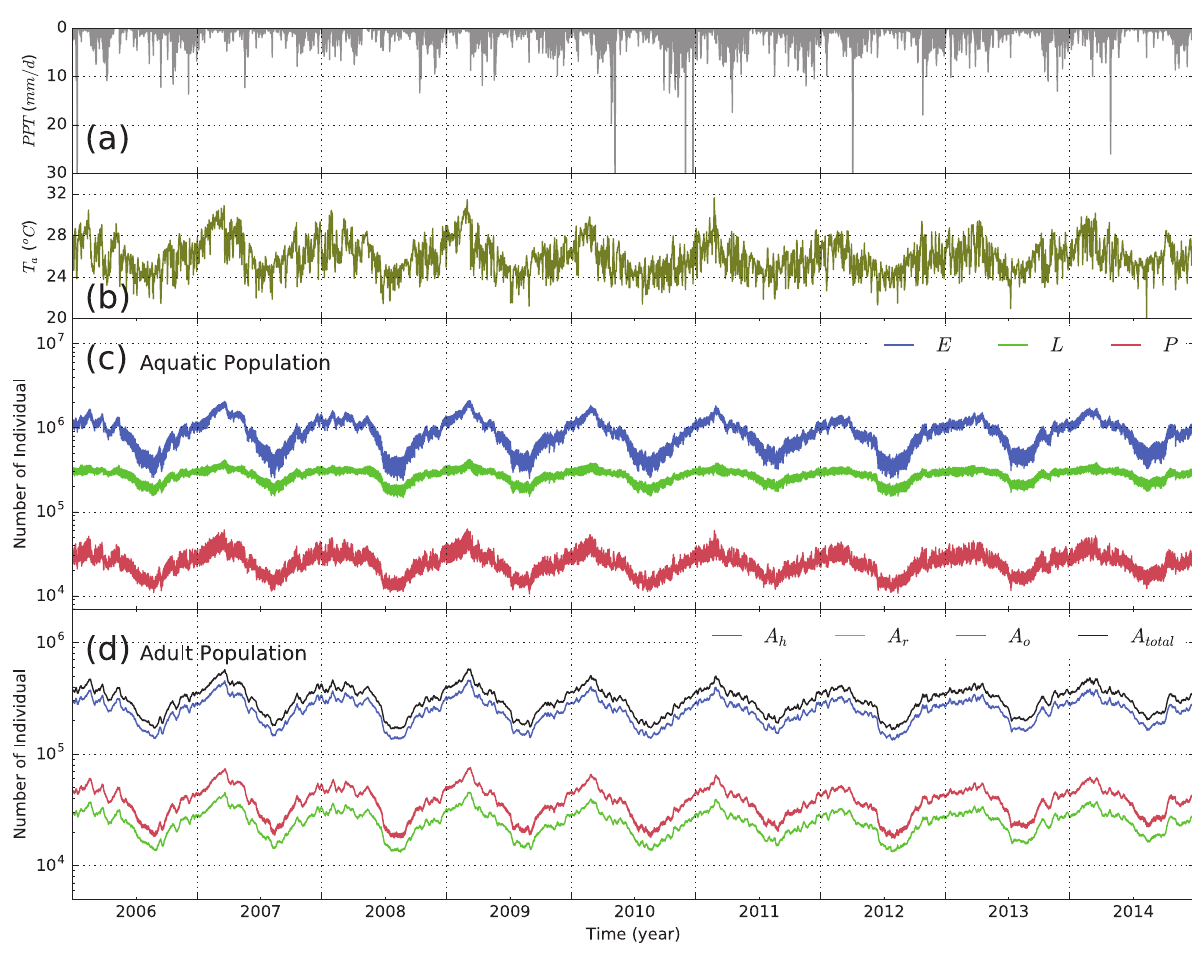
Fig 7. Key meteorological forcing data and variations of mosquito populations in scenario S0). (a) Daily precipitation; (b) Mean daily air temperature; (c) Population dynamics of mosquitoes in three aquatic phases (egg E , larval L , and pupal P ) in the S-ELPAs model; and (d) Population dynamics of mosquitoes in three adult stages (host seeking A sum of adult mosquitoes in all phases.